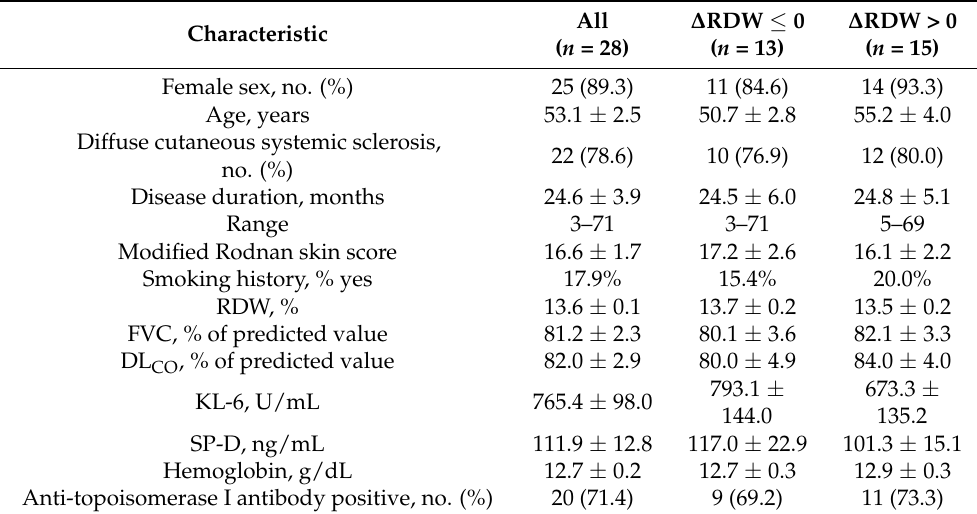
Table 1. Baseline characteristics of